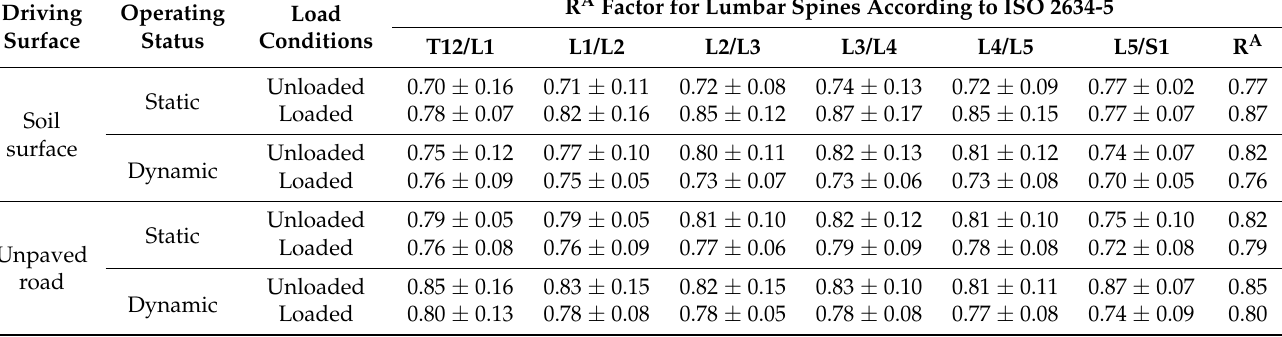
Table 7. Risk Factor (R A ) estimation according to ISO 2634-5.